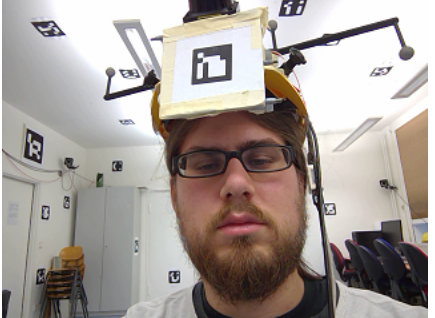
Figure 1. The helmet-based tracking system proposed in (Urban, 2016) with an additional ArUco-Marker (Garrido-Jurado et al., 2014) from the perspective of the front camera of the hand-held